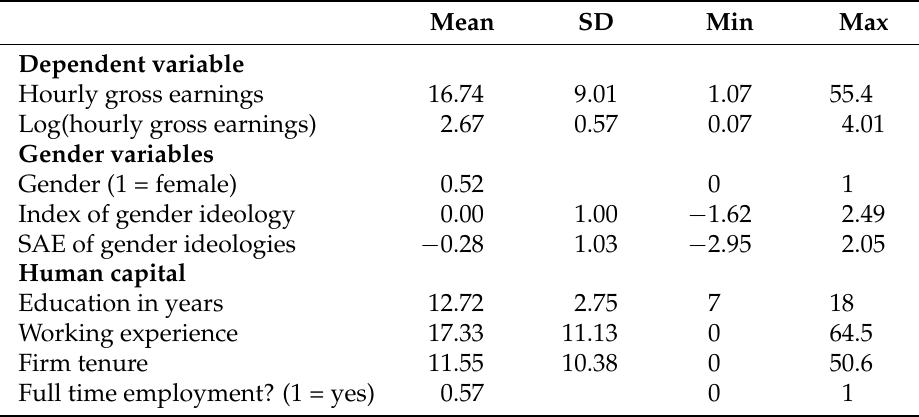
Table A1. Descriptive Statistics of Analytic